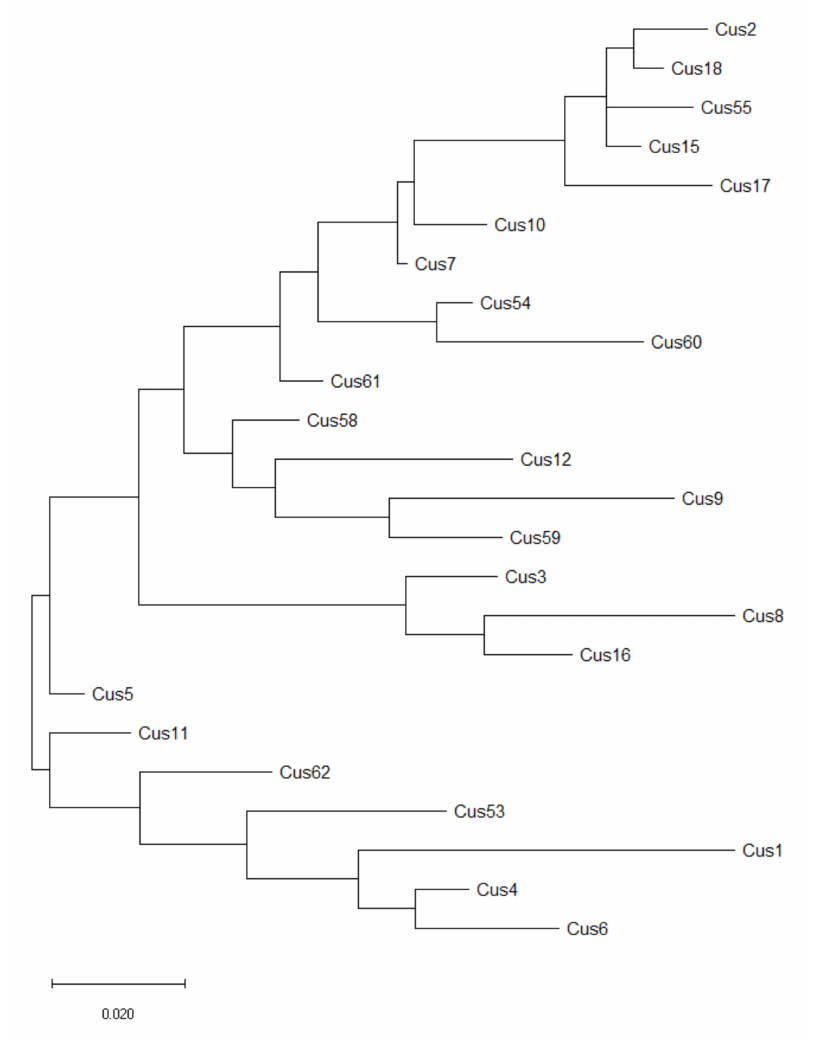
Figure 5. Maximum likelihood phylogenetic tree of Cuscuta campestris populations based on ITS and 5.8S ribosomal gene DNA sequences. Abbreviations correspond to those represented in Table